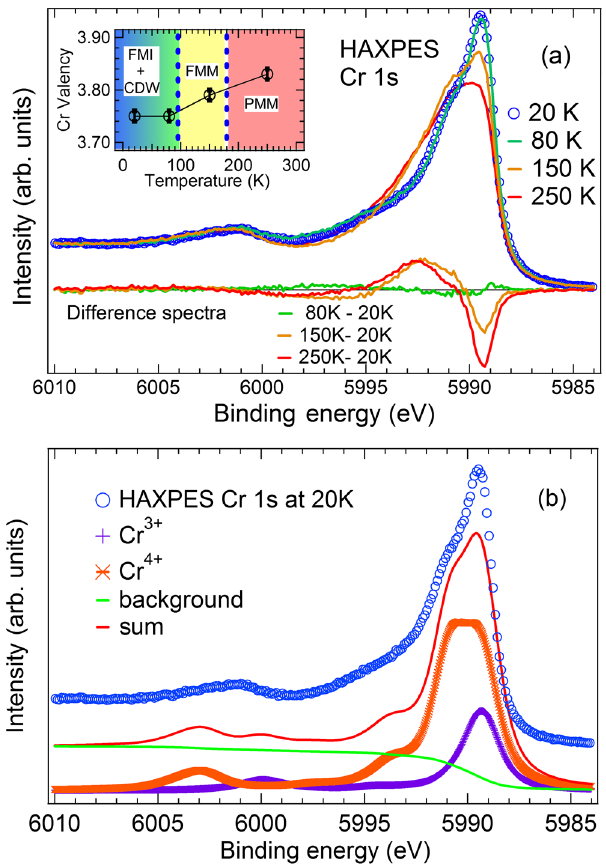
FIG. 4. Cr 1s core-level spectra of K 2 Cr 8 O 16 . (a) T -dependent Cr 1s core-level spectra obtained using HAXPES show clear changes across the paramagnetic-metal (PMM)-to-ferromagnetic- metal (FMM) transition, but negligible change is seen between 80 K and 20 K in the Peierls ferromagnetic-insulating phase. The observation indicates that the average Cr valence gets pinned to Cr þ 3 . 75 in the Peierls phase. The inset shows the estimated average Cr valency as a function of T . (b) The T ¼ 20 -K spectrum can be synthesized using the Cr 4 þ and Cr 3 þ spectra calculated using a cluster model and added in a ratio of 3 ∶ 1 , representing the average